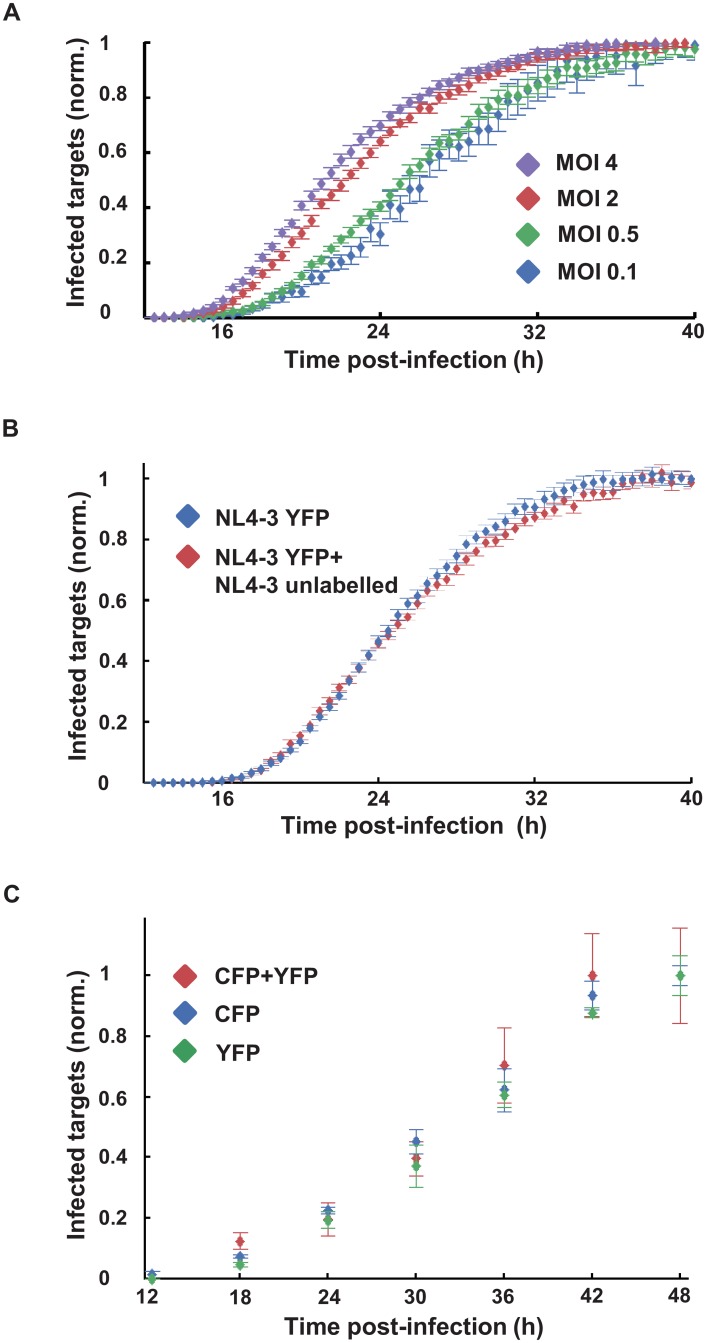
Earlier onset of HIV gene expression by multiple infections per cell.(A) Timing of HIV gene expression onset as a function of multiplicity of infection (MOI) per cell. MT4 cells were infected with HIV strain NL4-3YFP at an MOI of 0.1 (blue), 0.5 (green), 2 (red) and 4 (purple). Shown are means and standard errors over 15 FOVs. One of three independent experiments. (B) Measurement of cooperativity between infecting viruses. Infection as detected using YFP expression when cells were infected with NL4-3YFP alone at MOI of 0.3 (blue), or with YFP at the same MOI co-infected with unlabeled NL4-3 at an MOI of 8 (red). Shown are means and standard errors over 25 FOVs. One of three independent experiments. For both experiments, frequencies of infected cells were normalized by mean infected cell frequency in the last 3 hours of the movie. (C) Measurement of cooperativity in onset of HIV gene expression in CD4+ T cell infection. Cells were infected with NL4-3YFP and NL4-3CFP, and single (CFP or YFP) and double infected (CFP+YFP) cells were quantified by flow cytometry at the indicated time points. The frequency of CFP, YFP, and CFP+YFP positive cells normalized to the frequency at 48 hours post-infection is indicated by blue, green, and red points respectively. Shown are mean and standard errors of quadruplicate measurements of one representative experiment out of three, using three different blood donors.